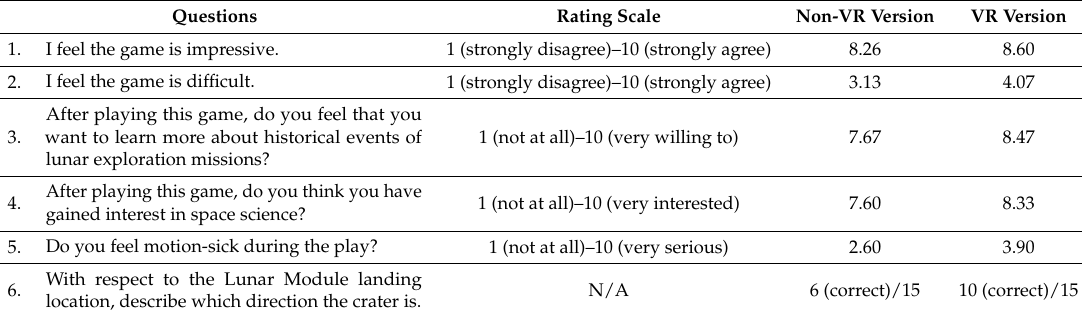
Table 2. Interview questions and the results.